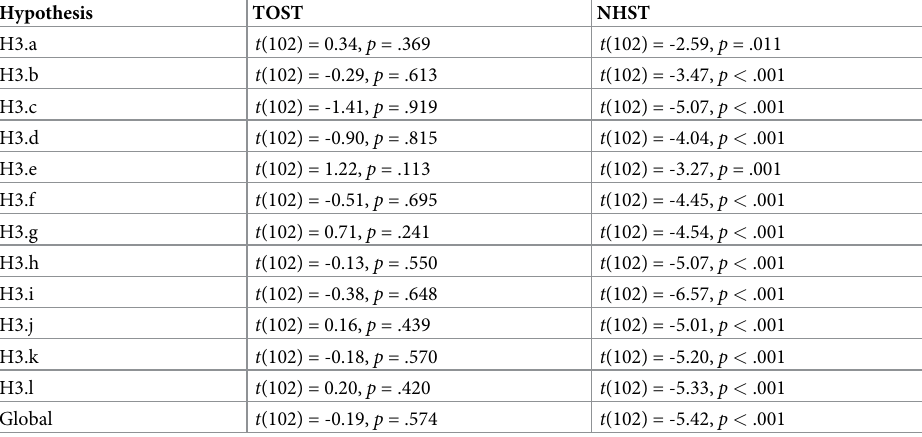
Table 9. Tests statistics for each hypothesis 3 and for their combination.